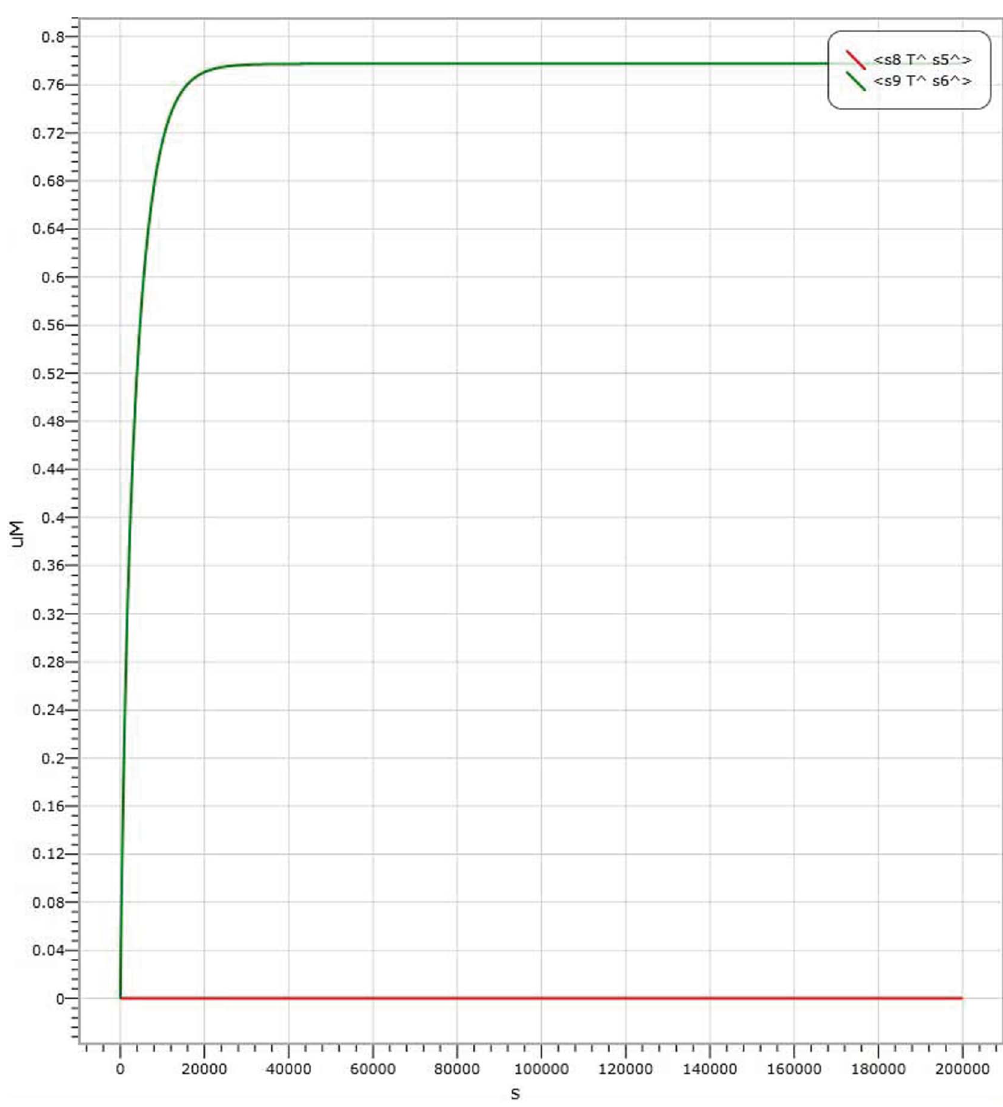
Figure 6. Visual DSD simulations of AND logic gate with input signal ‘‘00’’.